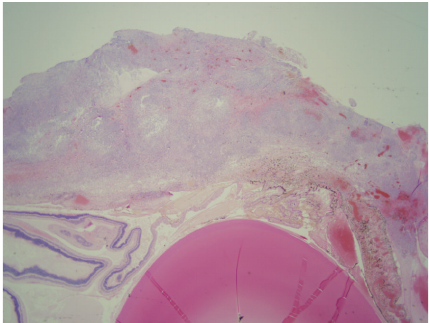
Figure 5: At the limbus, a markedly severe multinodular inflamma- tory infiltrate is present within and expanding from the limbus.